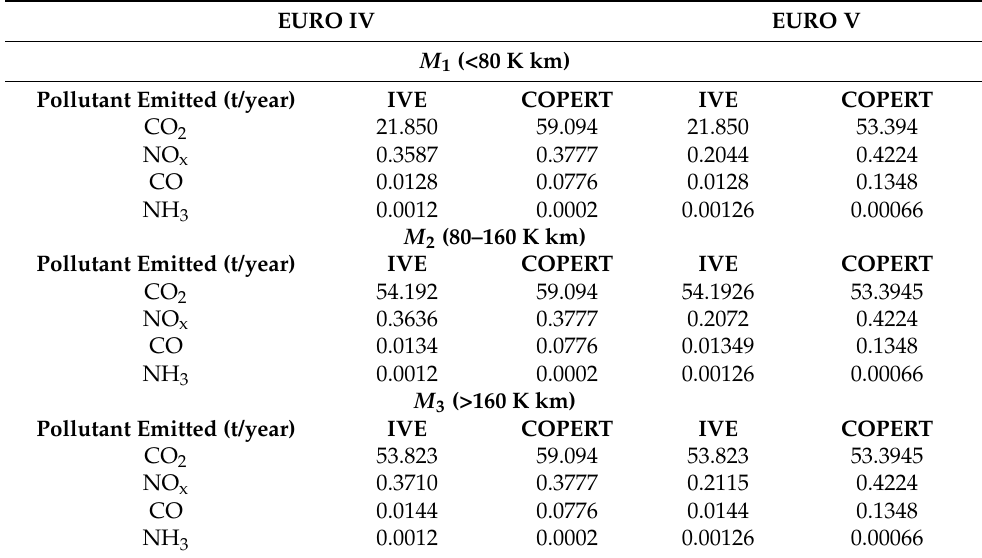
Table 5. Results from the compatibility